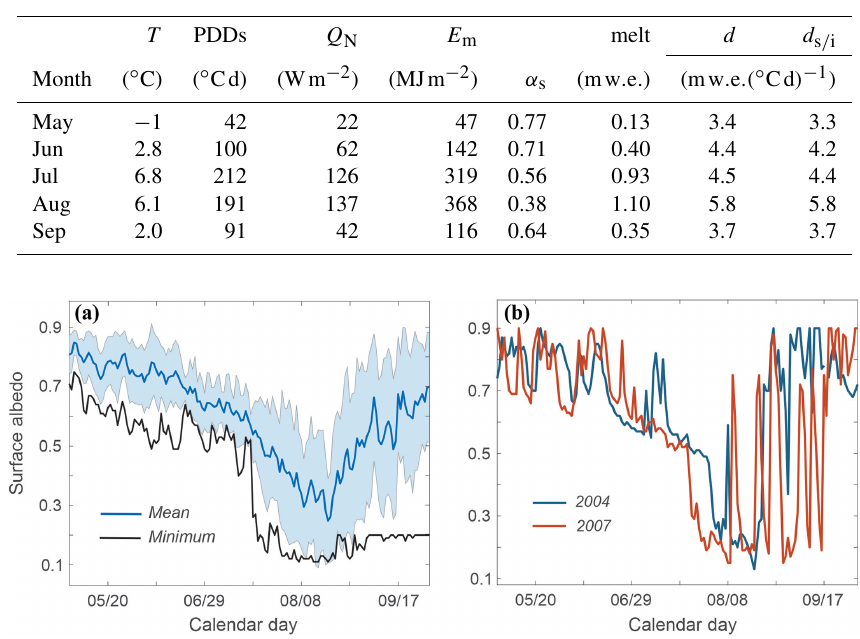
Figure 2. Daily albedo evolution at the Haig Glacier AWS site over the melt season, May to September. (a) Mean and minimum daily albedo from 2002 to 2016. Shaded area indicates the 1-SD range about the mean. (b) Select individual years (2004 and 2007) to better illustrate the transition from seasonal snow to exposed glacier ice and the albedo spikes associated with summer snow